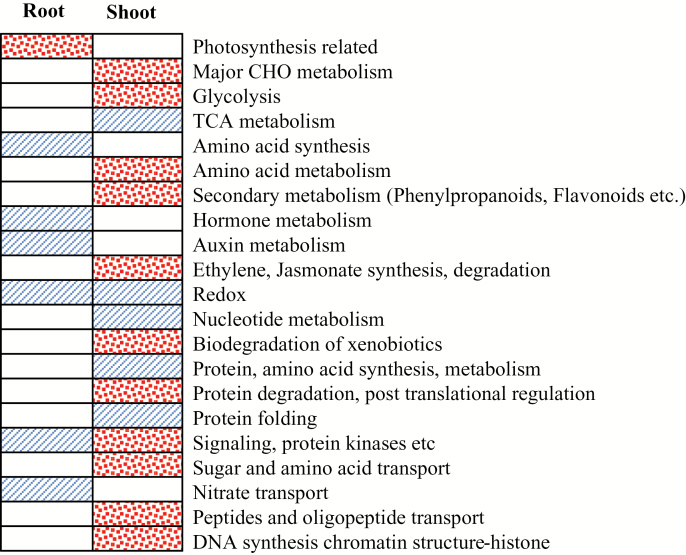
Pageman analysis reflecting changing in mit-2 root and shoot. The bins shown as stippled boxes are significantly up-regulated, while the bins shown as cross-hatched boxes are significantly down-regulated according to Pageman analysis (Wilcoxon test with BH correction, MapMan 3.6.0RC1). (This figure is available in colour at JXB online.)